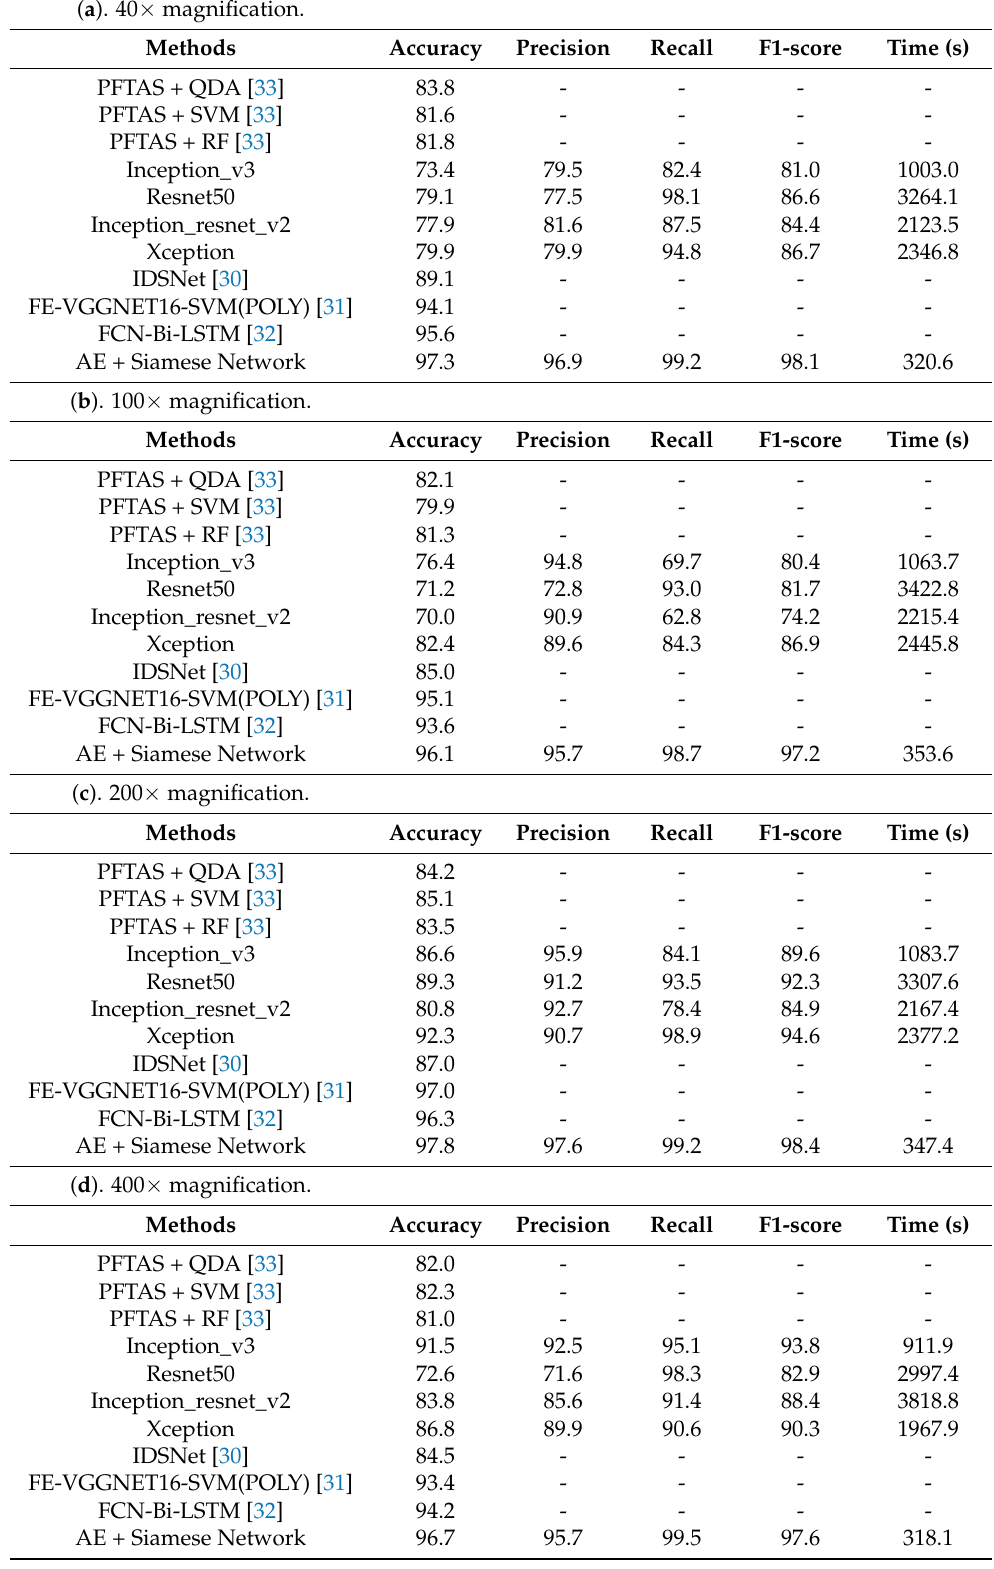
Table 3. Comparison of the performance (%) of AE + Siamese Network with other methods. ( a ). 40 ×